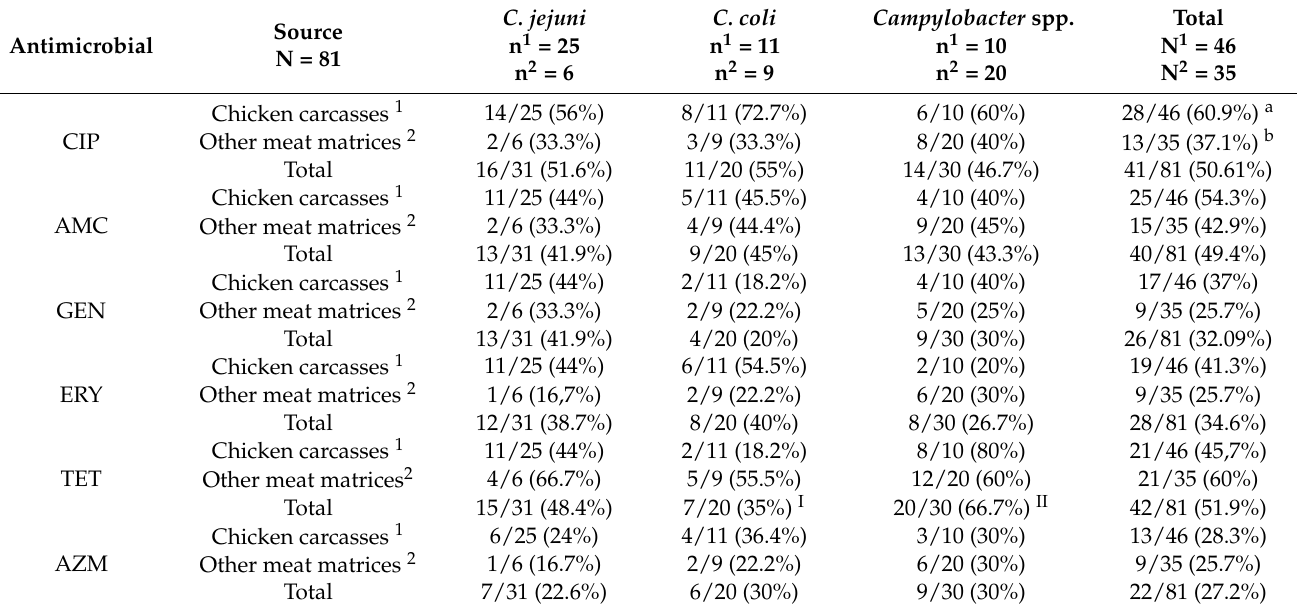
Table 4. Antimicrobial resistance in Campylobacter strains isolated in the